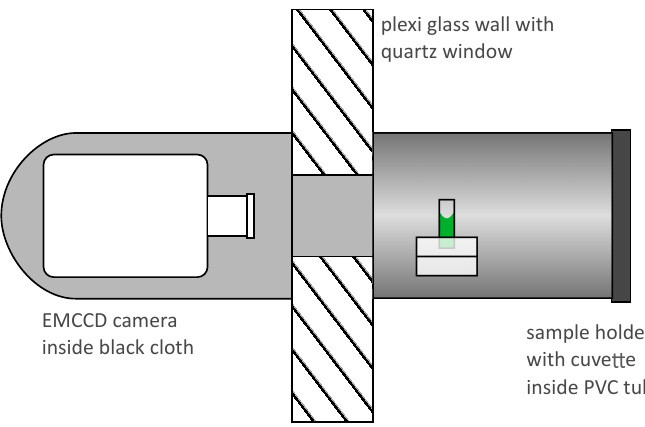
Figure 1. Schematic of the arrangement designed to image radioluminescence: A liquid or solid alpha active sample (green) resides on a holder placed inside black and light-tight PVC tube. The tube is placed around a glove port of box which is holding a quartz glass window instead of a glove. Light exiting the glove box through the window form an image on the sensor of an EMCCD camera. Multiple layers of black fabric wrapped around the camera and the glove port prevent stray light form entering the setup.